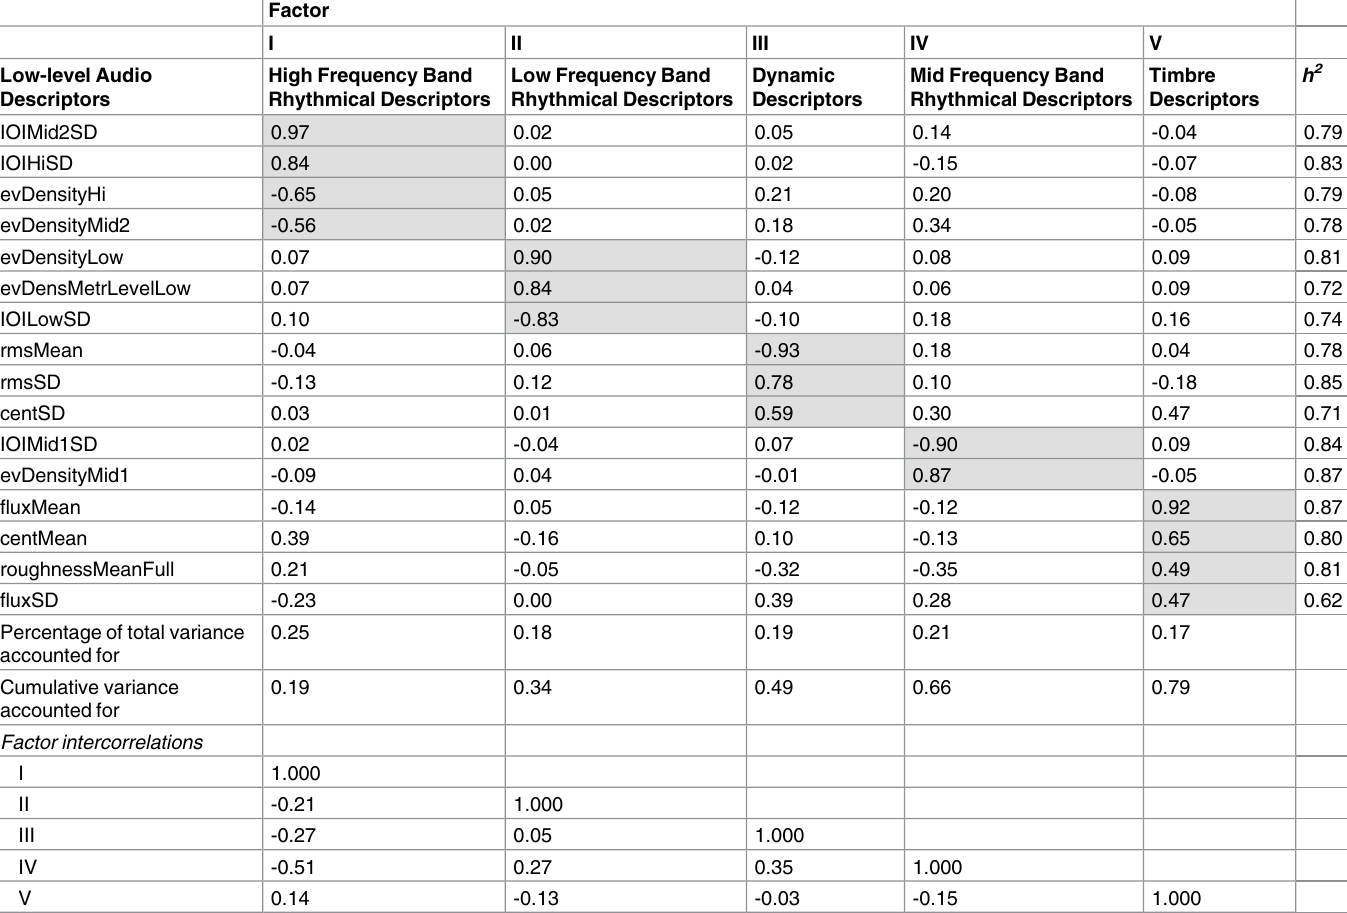
Table 1. Pattern Factor Loading, Communalities, Variance, and Factor Correlations Based Upon a Principal Components Analysis (PCA) Factor- ing with Oblim Oblique Rotations for 16 Audio Feature Variables. Grey areas indicate the low-level audio descriptors that characterize the respective